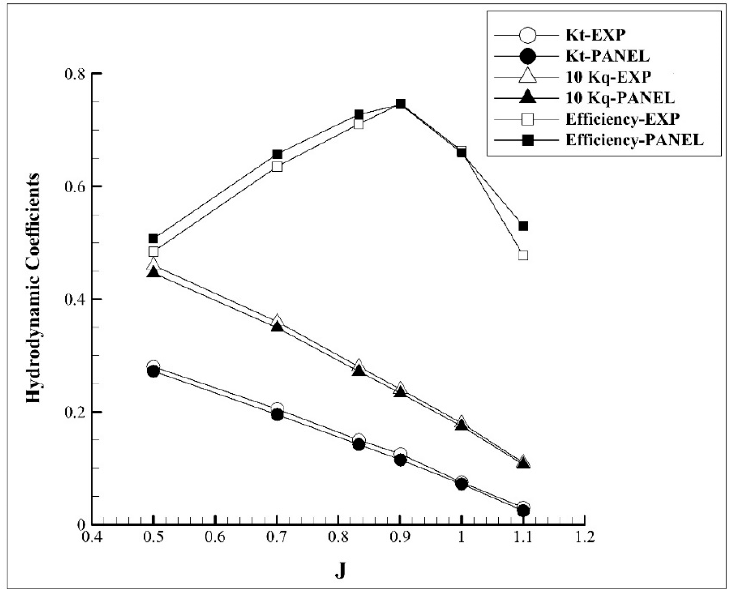
Figure 7. Hydrodynamic coefficients of DTMB 4119 propeller.